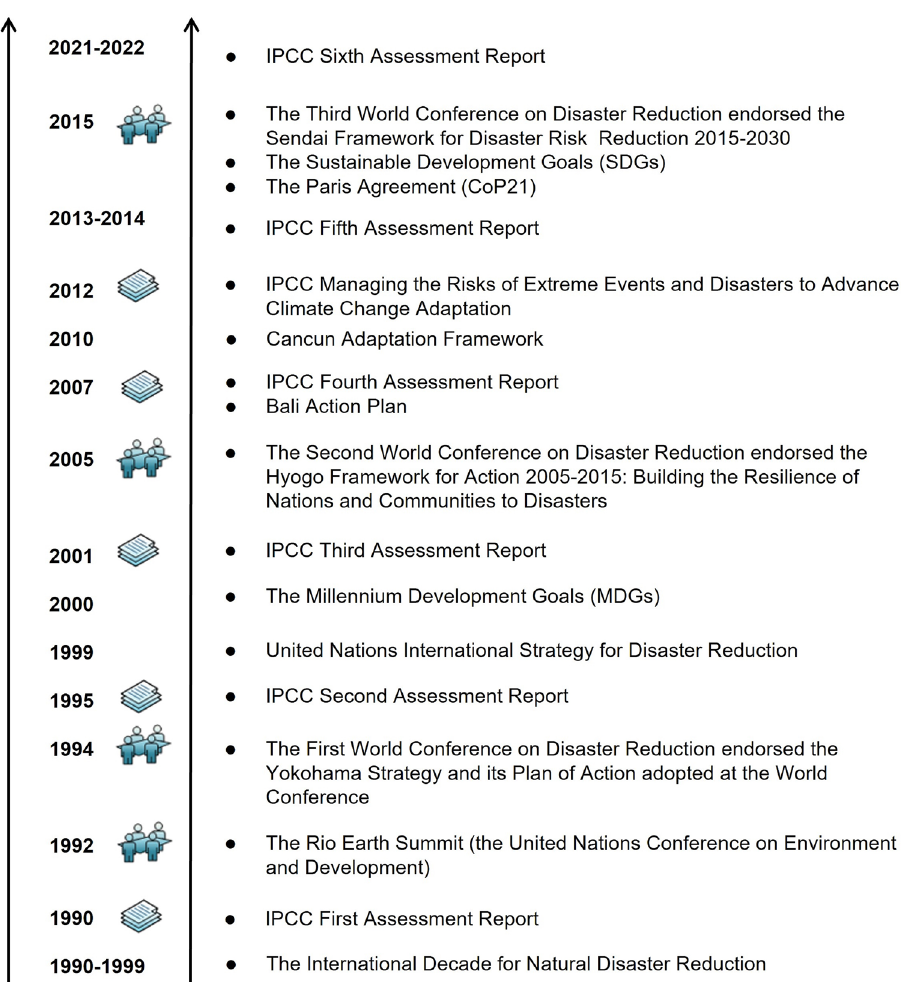
Fig. 1 Important events of dis- aster risk reduction (DRR), cli- mate change adaptation (CCA), and sustainable development since 1990. IPCC: Intergov- ernmental Panel on Climate Change. Source Modified from Mal et al.